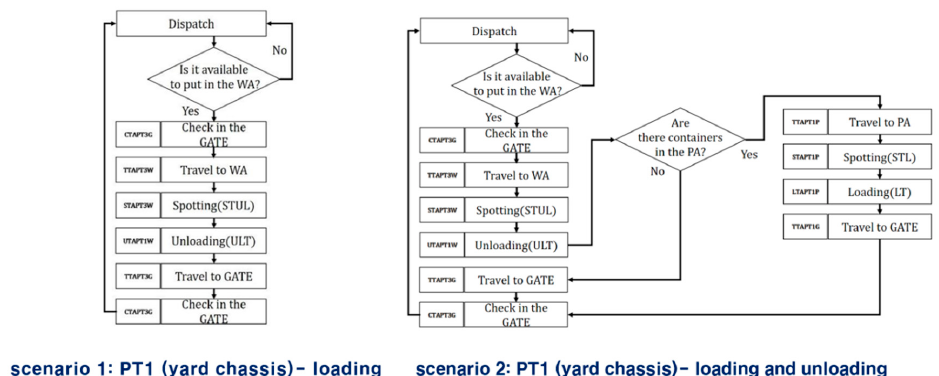
Figure 13. Simulation algorithm for private tractor (PT) (scenario 1 for yard chassis).